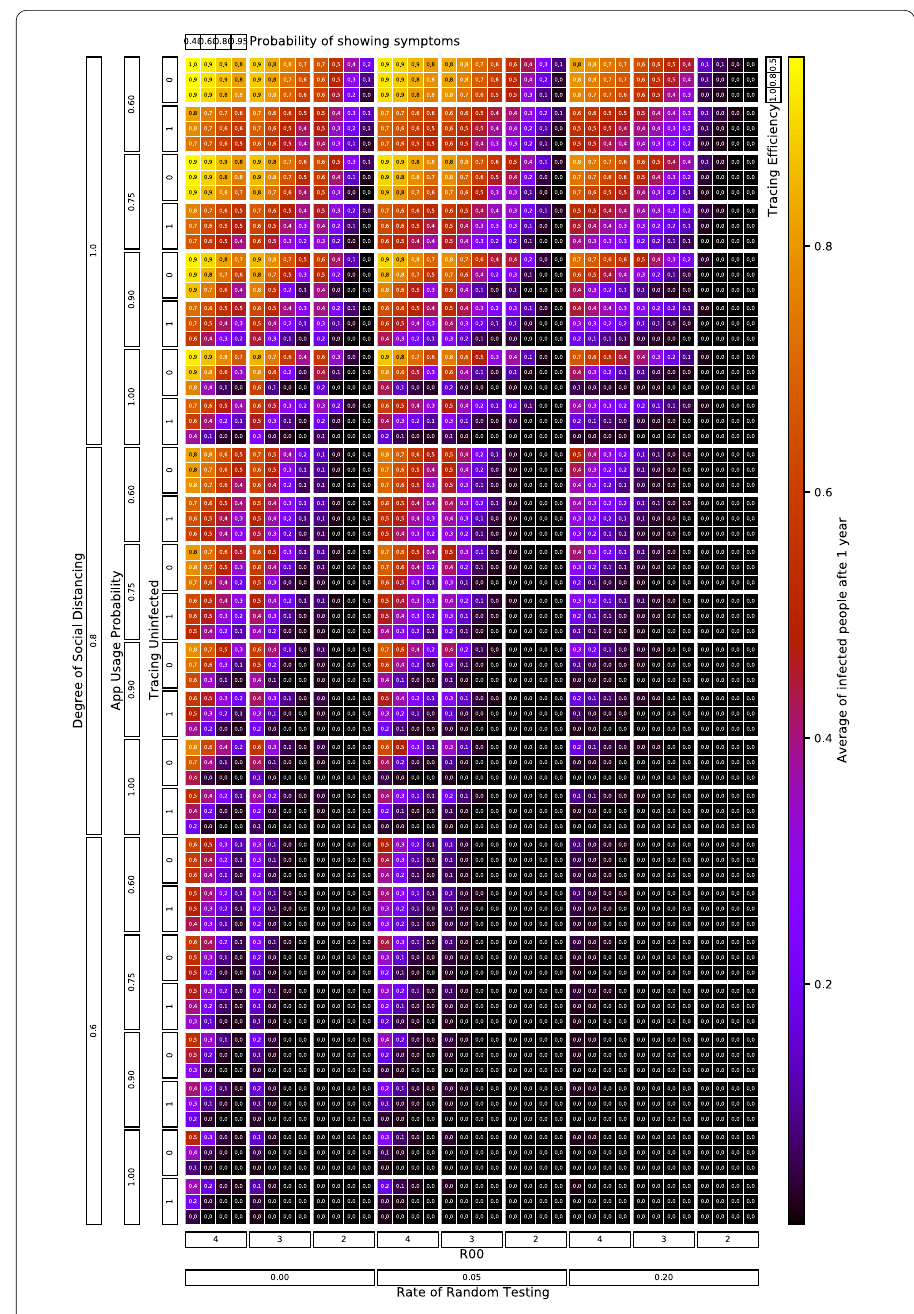
Figure 26 The total fraction of the population that has been exposed one year into the outbreak is shown for all combinations of parameters in the default parameter scan (black font color in Tab.